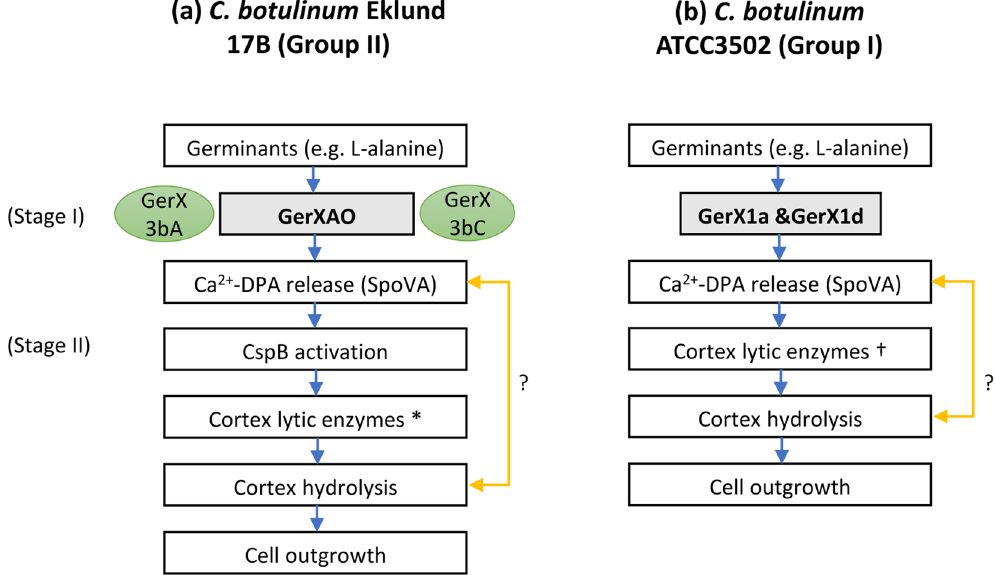
Figure 5. Comparison of the models proposed for the germination pathways of C . botulinum Group I and Group II. ( a ) Group II, with GerXAO (shaded grey) as the major germinant receptor and GerX3bA & GerX3bC (shaded green) involved in germination rate. Initially, L-alanine binds to the GerXAO receptor, followed by Ca 2 + -DPA release through the SpoVA channel (Stage I). In stage II, the cortex lytic enzyme SleC is activated by CspB, followed by cortex hydrolysis, membrane, and coat degradation, the resumption of metabolism and ultimately cell outgrowth. * Cortex lytic enzymes include SleC2 a/b and SleB2. ( b ) Germination pathway for C . botulinum strain ATCC3502 (Group I) 37,39 . This system involves the recognition of nutrient germinants by their cognate receptor GerX1a &GerX1d acting together, followed by Ca 2 + -DPA release through the proposed SpoVA channel (Stage I). In stage II, the CLEs CwlJ and SleB (†) are activated, followed by cortex hydrolysis, membrane and coat degradation, the recommencement of metabolism and eventually cell outgrowth. “?” indicates that the timing of the release of Ca 2 + -DPA is presently unknown in C . botulinum Group I and Group II and may be released following germinant binding or after cortex